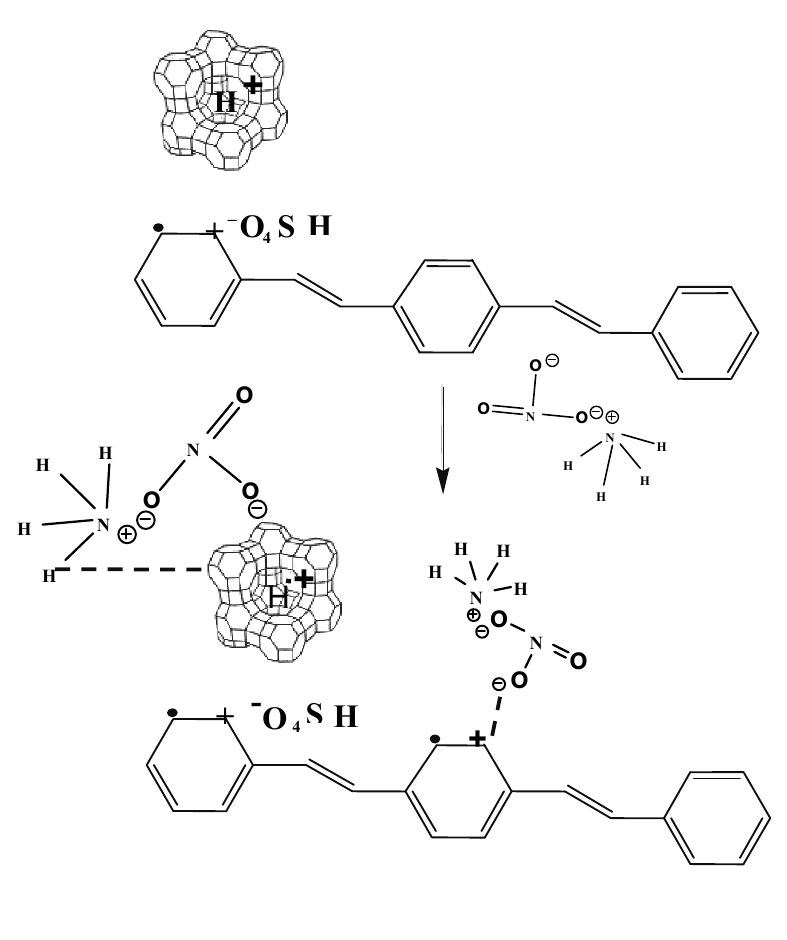
Figure 9. Schematic of the proposed interactions between NH dPPV/zeolite Y